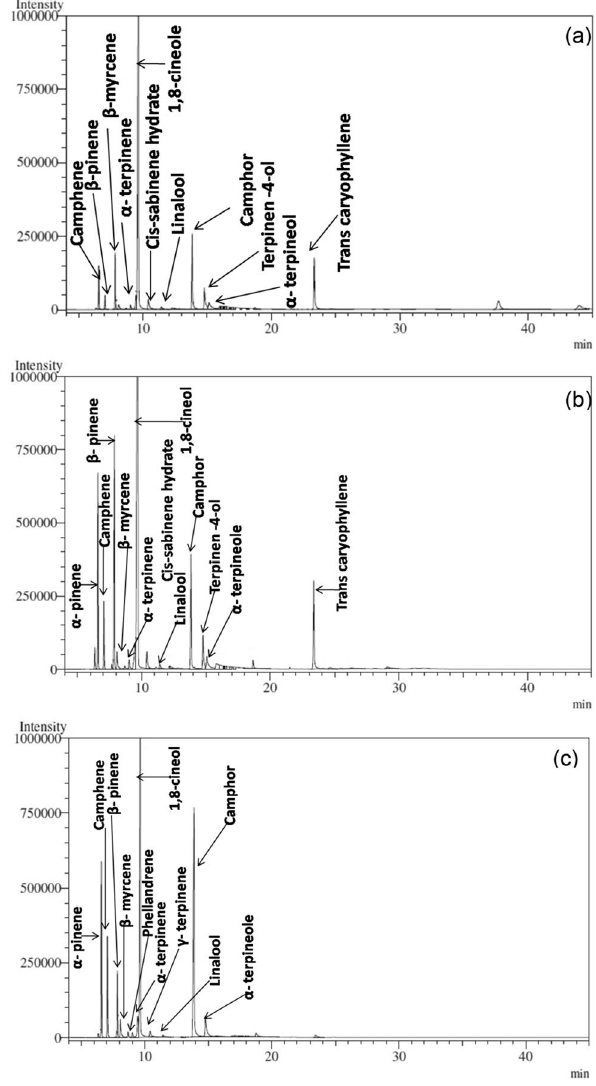
Figure 1. MS chromatograms of R. officinalis accession IHBT/RM/Ac-1 in ( a ) rainy season, ( b ) autumn season, and ( c ) summer